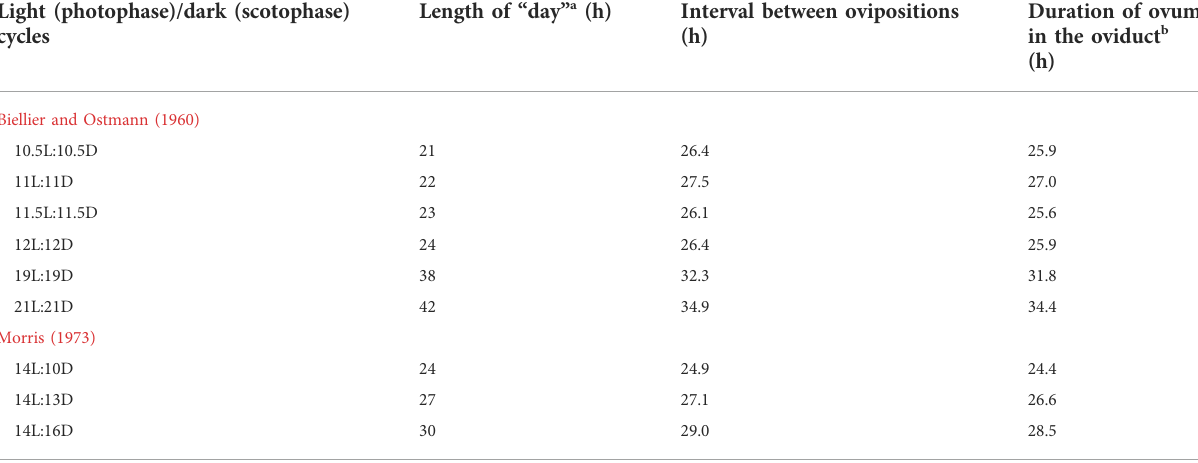
TABLE 2 Effect of ahemeral light/dark cycles on interval between ovipositions (based on or calculated from data in Biellier and Ostmann, 1960; Morris, 1973). Light (photophase)/dark (scotophase) cycles